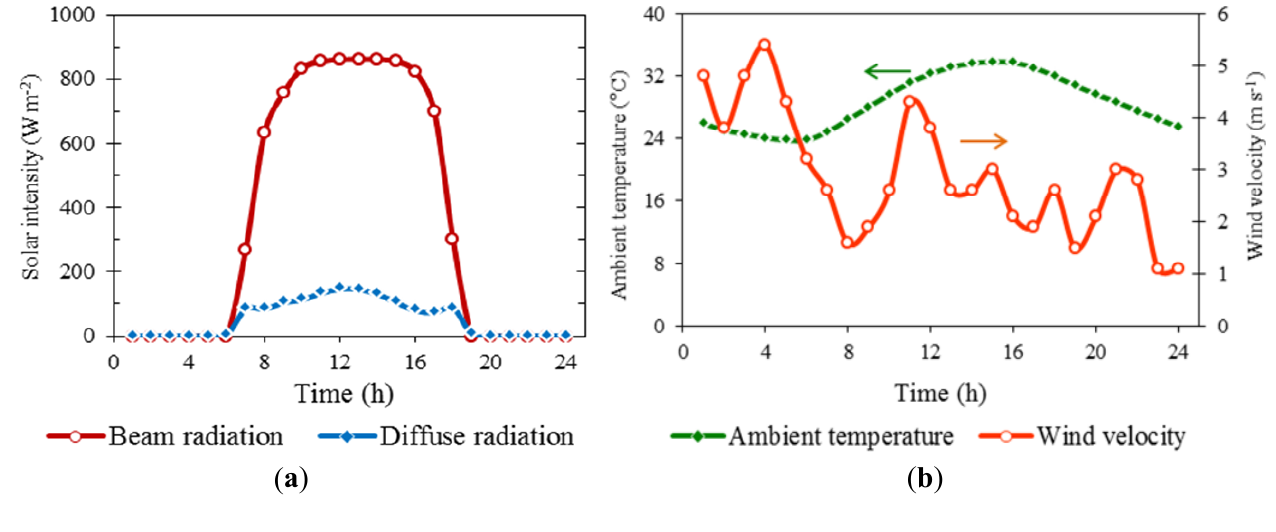
Figure 6. Weather data used in simulation for Tokyo on 28 August 2005: ( a ) solar beam and diffuse radiation; and ( b ) ambient temperature and wind